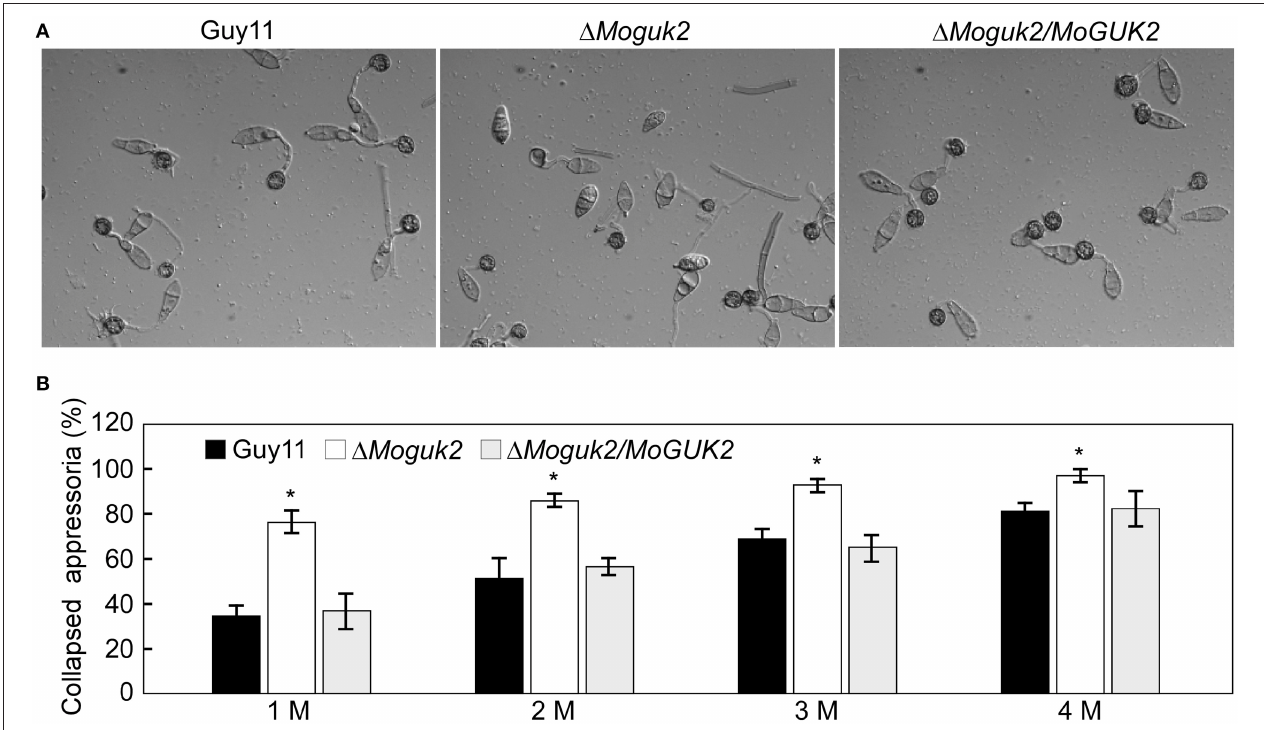
FIGURE 6 | The 1 Moguk2 mutant showed defects in appressorial formation and turgor. (A) Appressorial formation was observed on hydrophobic surfaces under a microscope at 24 hpi. (B) Appressorial turgor measurement. Error bars are standard deviations and asterisks represent significant differences at P < 0.01. All graphs represent three biological and three technical replicate